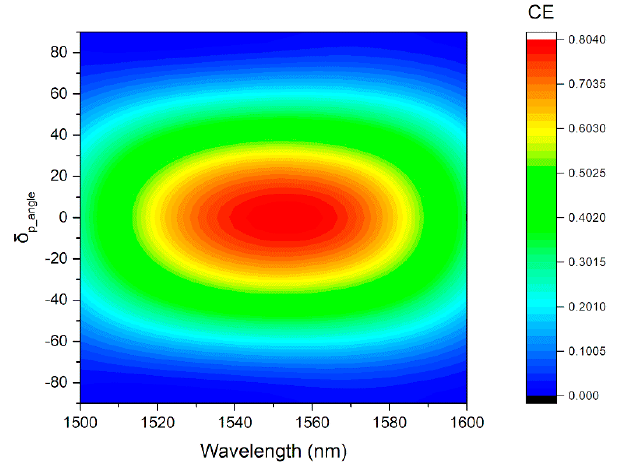
Figure 11. Dependence of coupling efficiency on deviation of the angle of polarization δ p_angle.